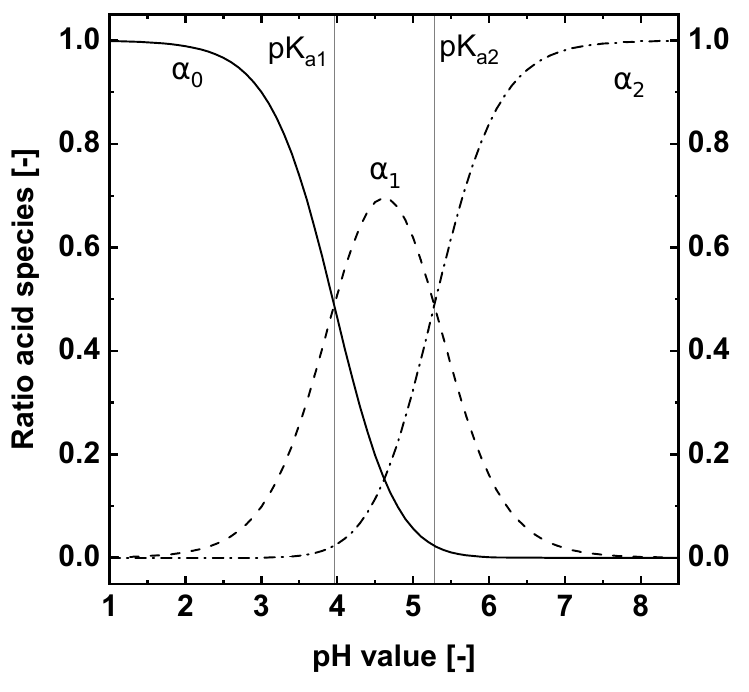
Figure 1. Dissociaction of succinic acid over the pH value calculated with the pK a1 = 3.96 and pK a2 = 5.28 reported by Arendt